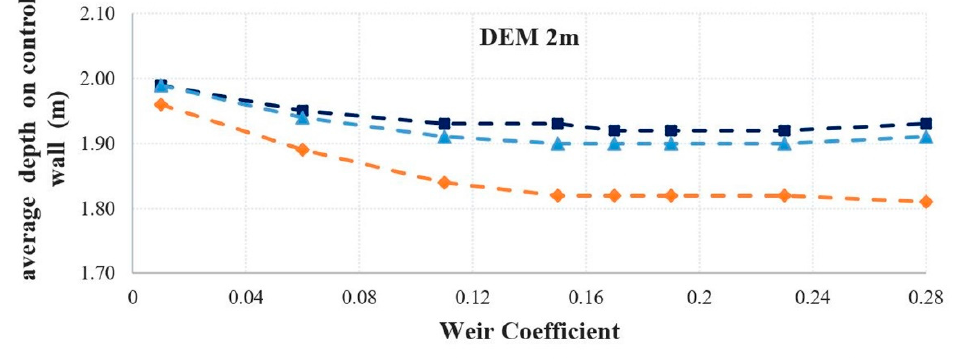
Figure 5. Simulated depth on control wall for varying Weir coefficient in the lateral structures and Manning’s roughness coefficient n f in the flow areas, through the coupled hydraulic 1D/2D HEC-RAS model, at high-resolution DEM 2 m × 2 m.